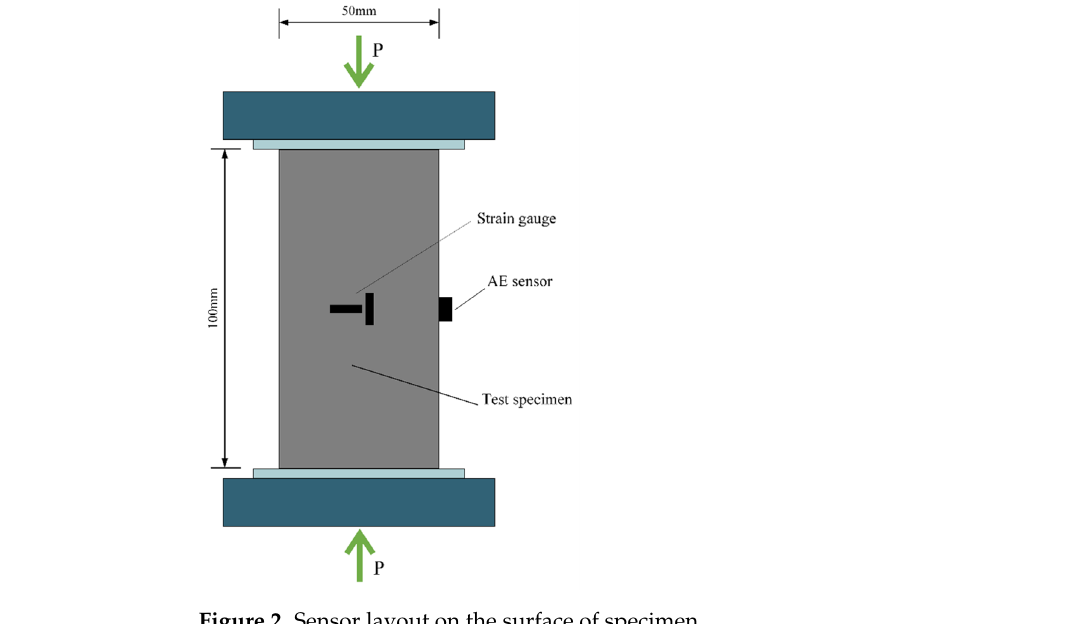
Figure 2. Sensor layout on the surface of specimen.